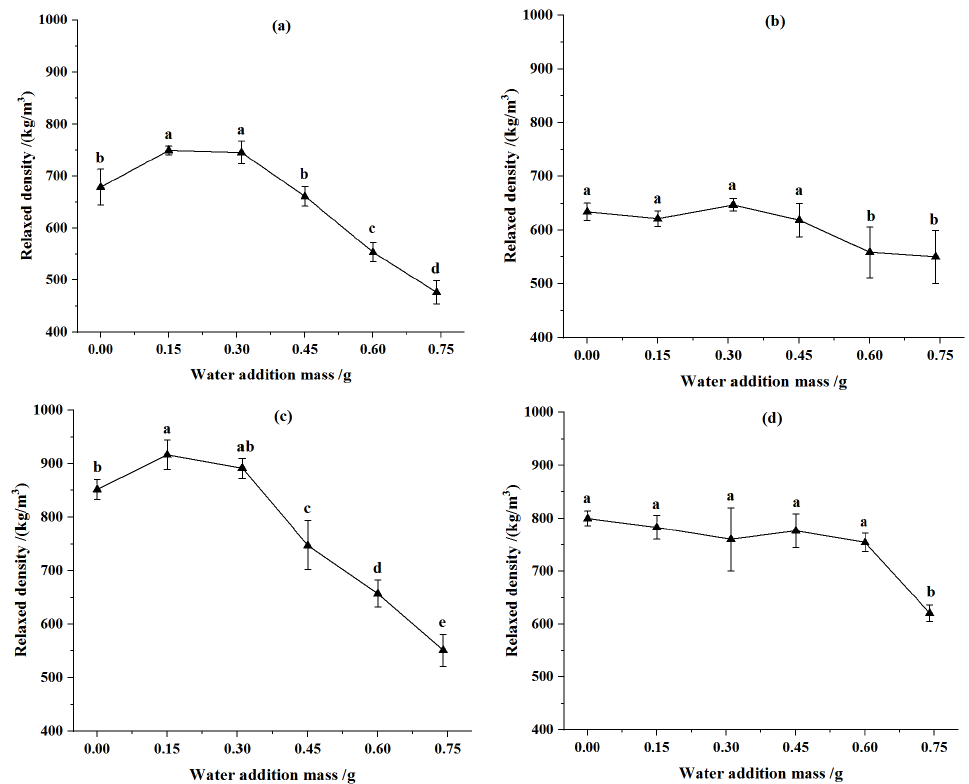
Figure 1. Effect of water addition on relaxed density of pellets. ( a ) Particle size was 2 mm and compression displacement was 90 mm. ( b ) Particle size was 4 mm and compression displacement was 90 mm. ( c ) Particle size was 2 mm and compression displacement was 92 mm. ( d ) Particle size was 4 mm and compression displacement was 92 mm. Note: Different letters in the same line chart indicate a significant difference between the data ( p < 0.05).